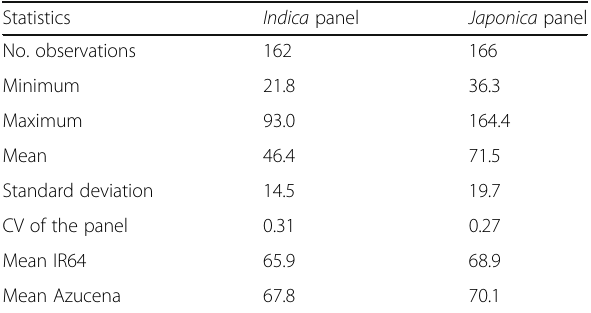
Table 1 Statistics of the indica and japonica panels for the root cone